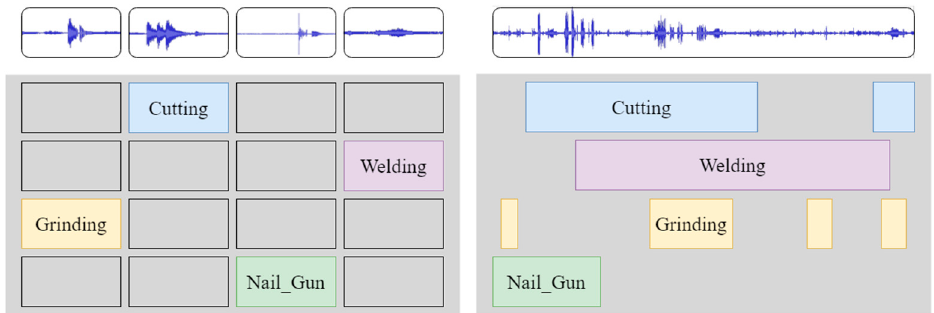
Figure 2. Comparison between our method and the existing research in construction management.